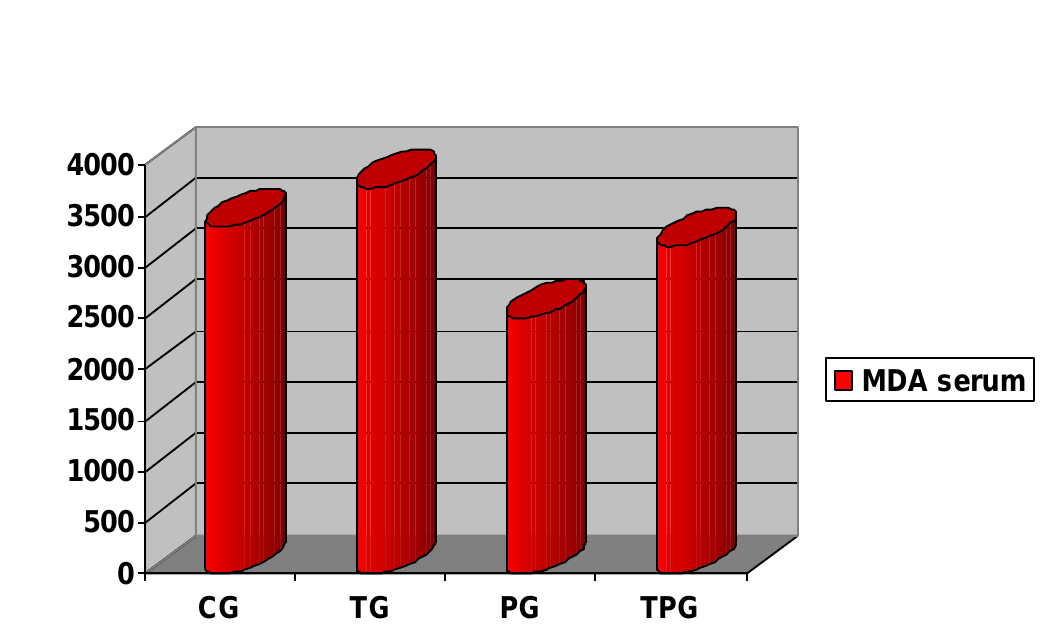
FIGURE 2 - Average concentration of malondialdehyde (ng/ml) in the serum collected on the seventh postoperative